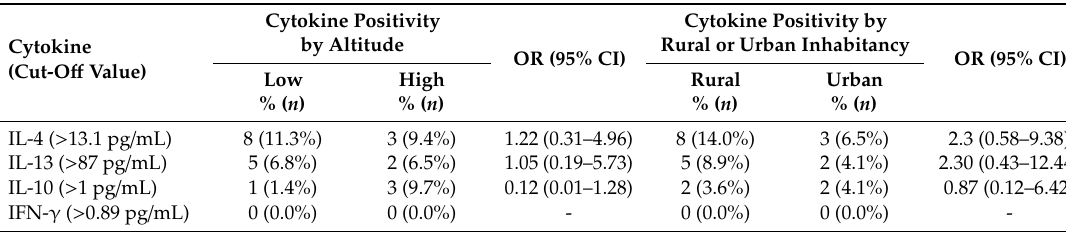
Table 2. The distribution of raised levels of cytokines among adult asthmatics with regards to altitude and urban versus rural